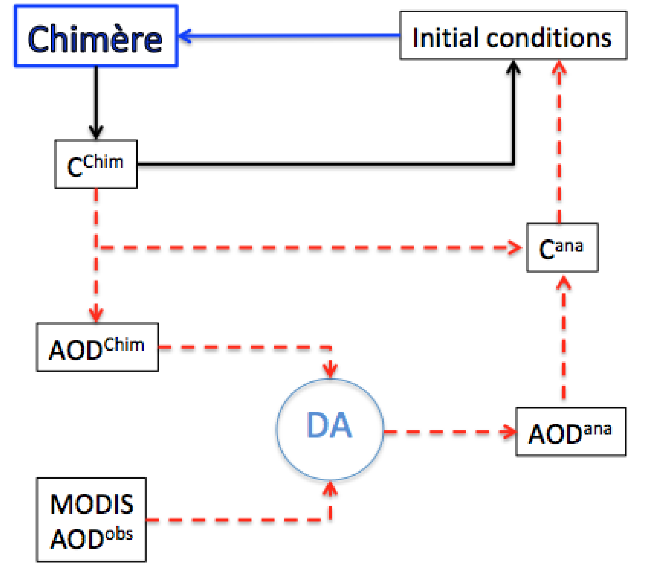
Figure 1. Illustration of the developed Analysis-Forecast cycling scheme. The blue arrow show the forecast step. The black arrows refer to the basic configuration of the model. The red arrows refer to the developed data assimilation